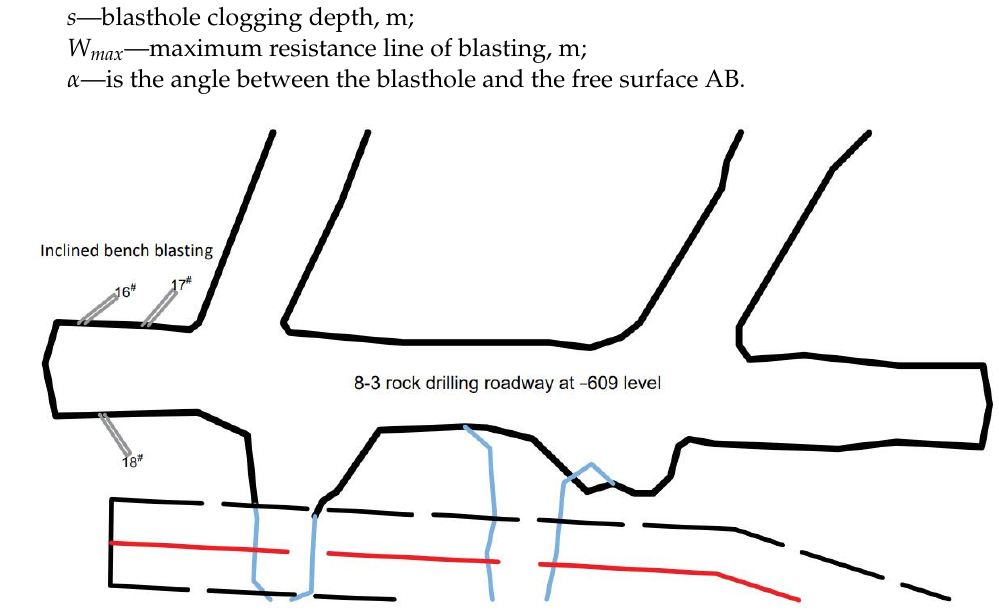
Figure 5. Schematic diagram of plane layout of hole in funnel test of inclined bench blasting. (In the figure, ‘ # ’ is for the convenience of numbering the holes, 16 # represents hole number one, and so on). There are three blastholes in the inclined bench blasting experiment, numbered 16–18, drilling depth is the same, and the angles between them and the wall of the roadway are 30 ◦ , 40 ◦ , and 50 ◦ ,